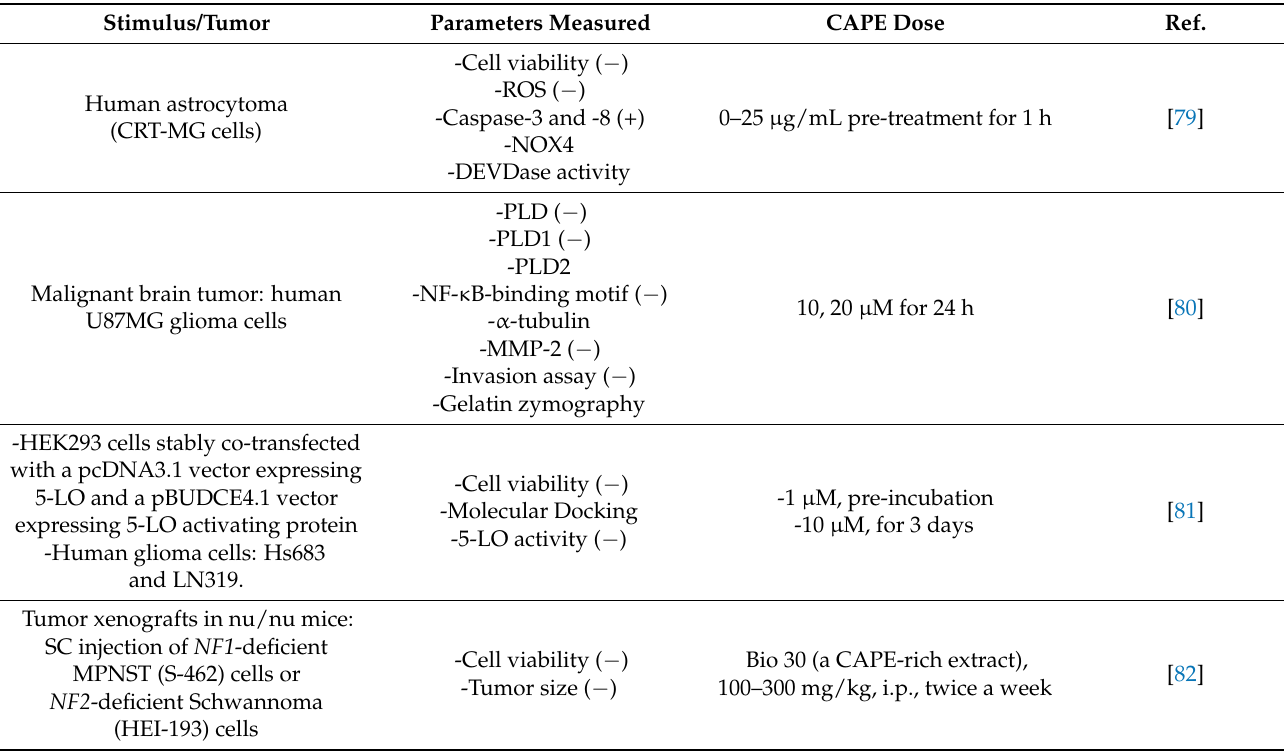
Table 5. CAPE anti-tumoral effects in CNS. Where applicable, the effect of CAPE on the parameters measured is reported between parentheses (+ or −